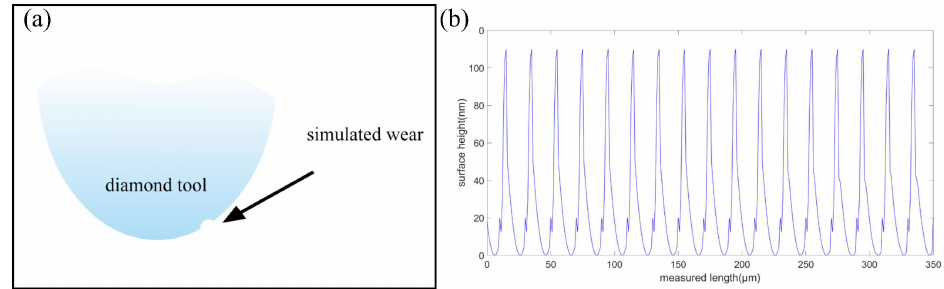
Figure 16. The simulated cross-sectional surface profile with tool wear taken into consideration.